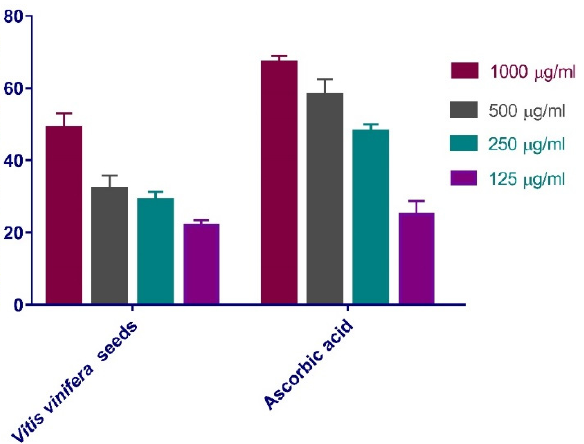
Figure 2. SOD scavenging power of V. vinifera seed extract at variant concentrations (1000 µg/mL, 500 µg/mL, 250 µg/mL, and 125 µg/mL). Bars illustrate mean ± SD (standard deviation). Significant difference among all groups is evaluated by a two-way ANOVA test.